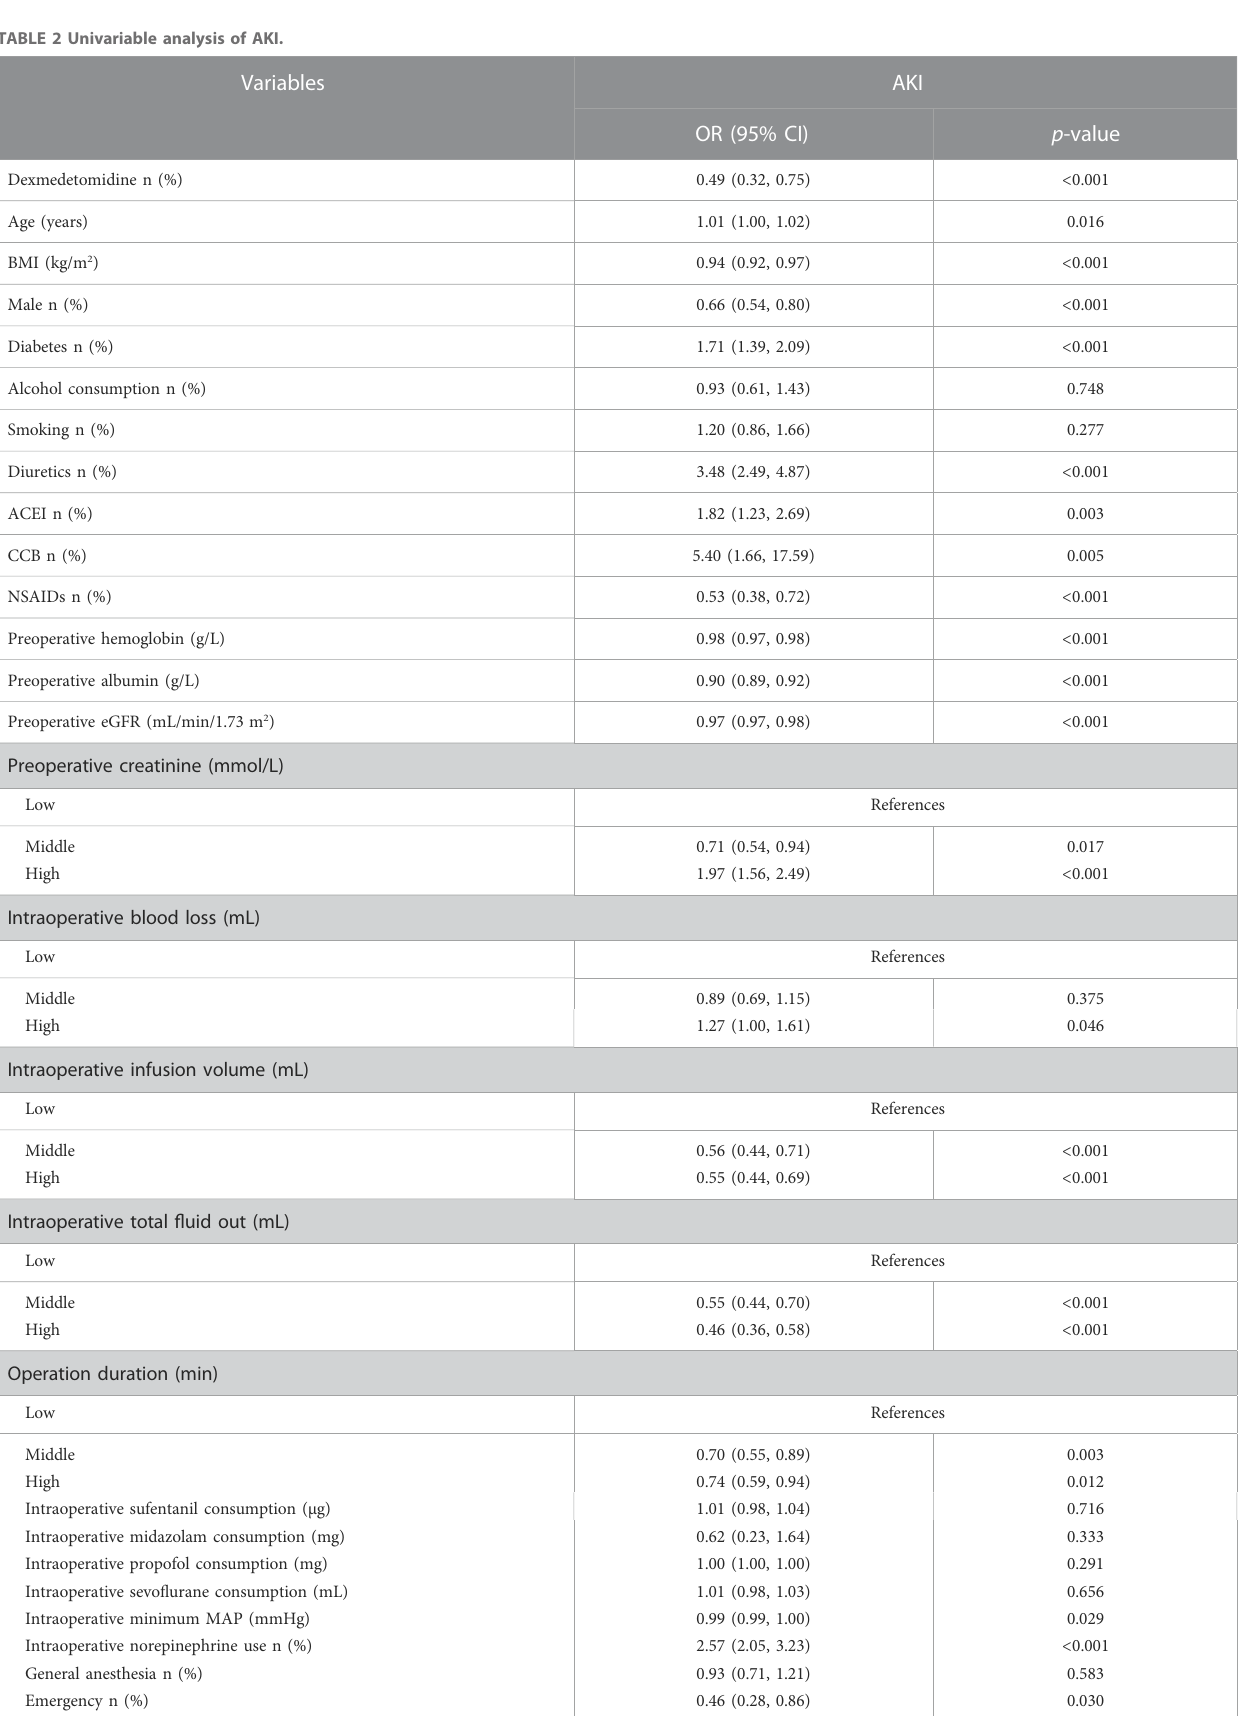
TABLE 2 Univariable analysis of